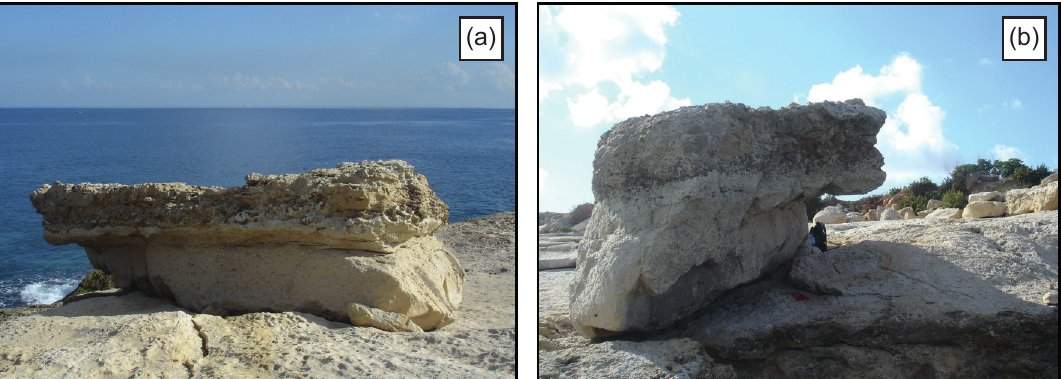
Figure 14. Inverted boulder AM1 that has pivoted over the LGL scarp: ( a ) the composite LGL / PCB boulder over 6 m long, resting atop the LGL scarp at an elevation of 6.5 m. Its inverted attitude is evidenced by the inversion of the two stratigraphic units; ( b ) this lateral view highlights the morphological aspects, which defines the basal shelf of the flipped boulder and the receding scarp on its right-hand margin. These forms are identifiable also on the cli ff top platform to the right. The similarity of morphologies of boulder and platform facilitates the interpretation that it originated parallel to the cli ffl ine, with the recessed mini scarp parallel to the